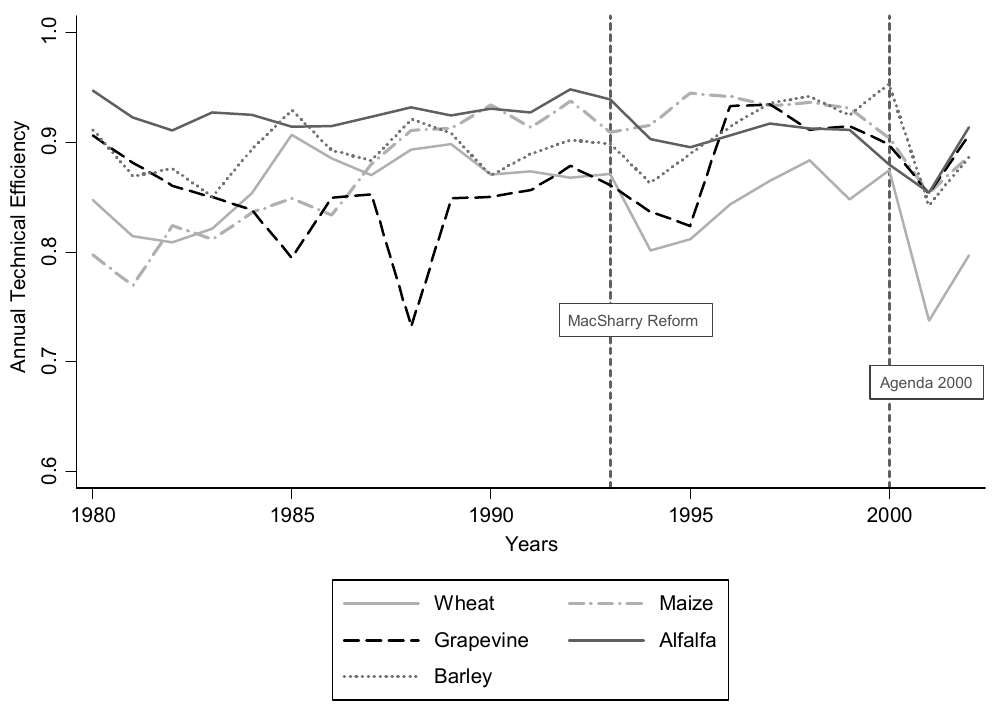
Figure 4. Temporal prediction on average technical efficiency related to PAC policy